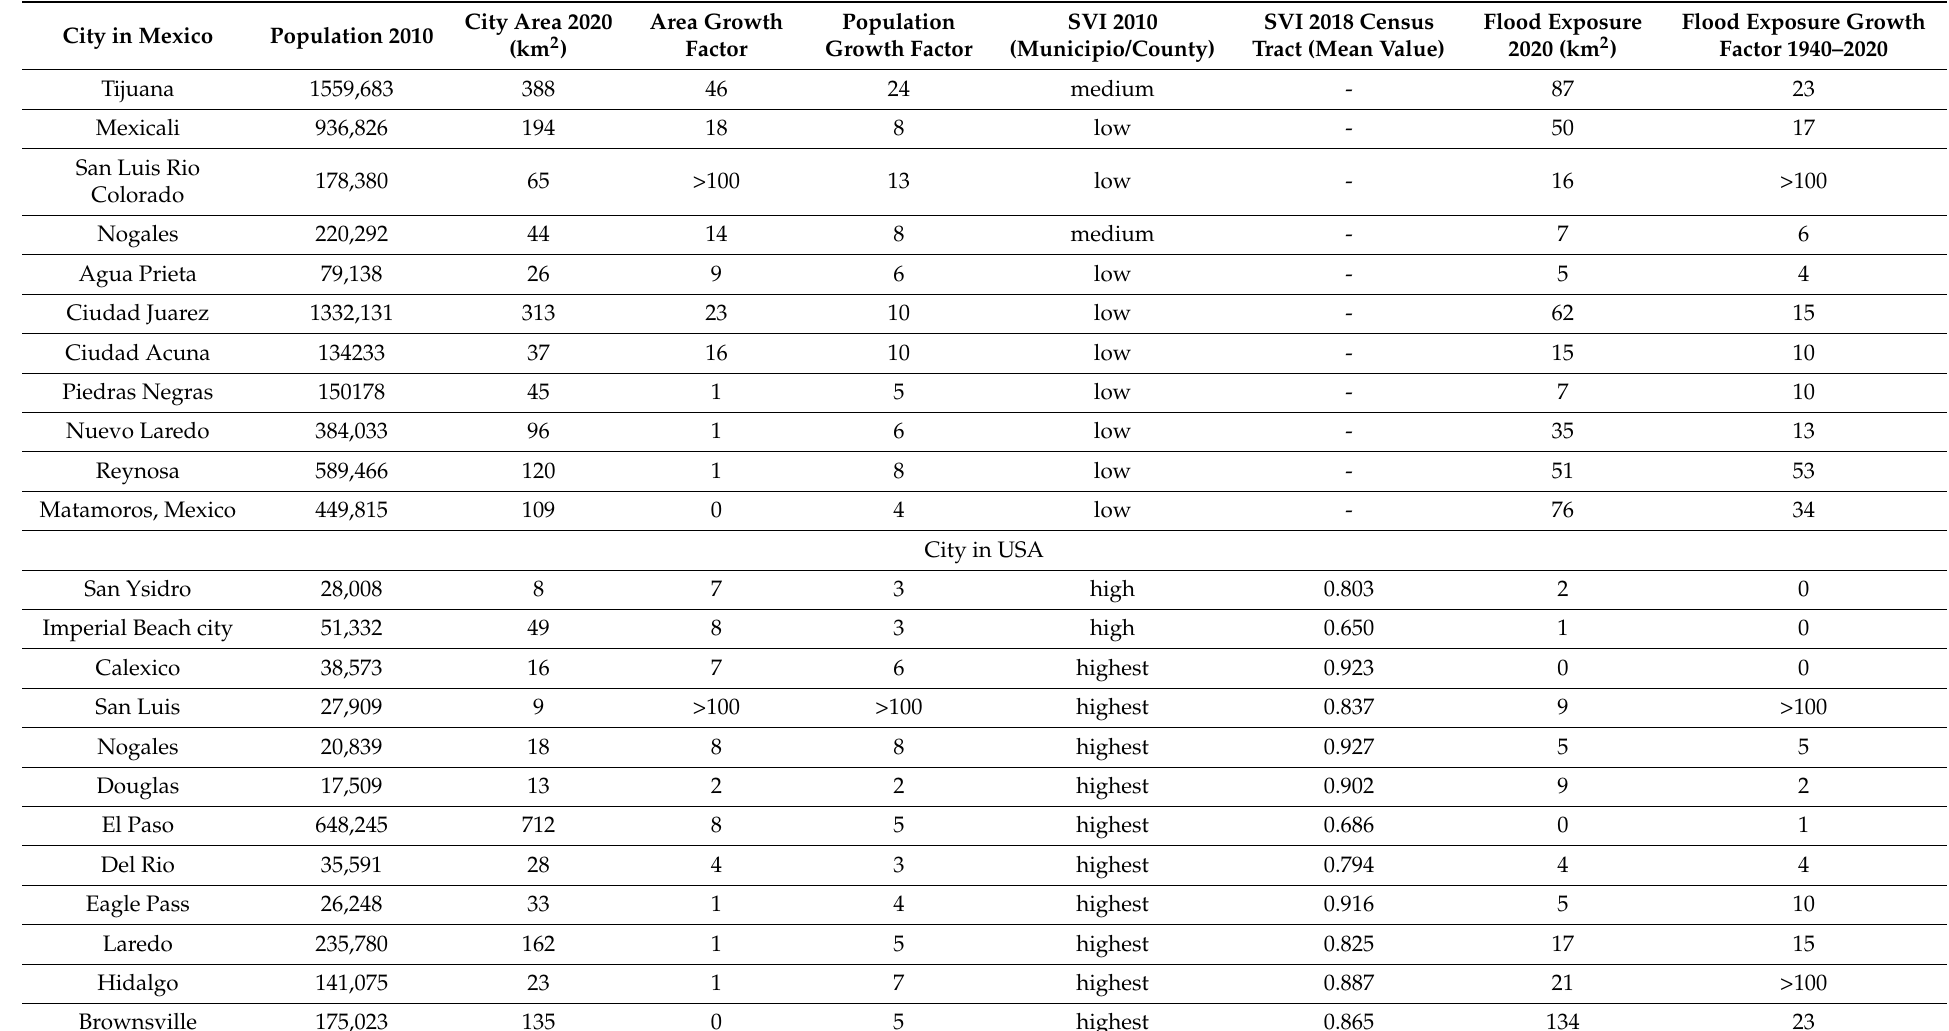
Table 7. Summary of urban growth and risk factors analyzed in this